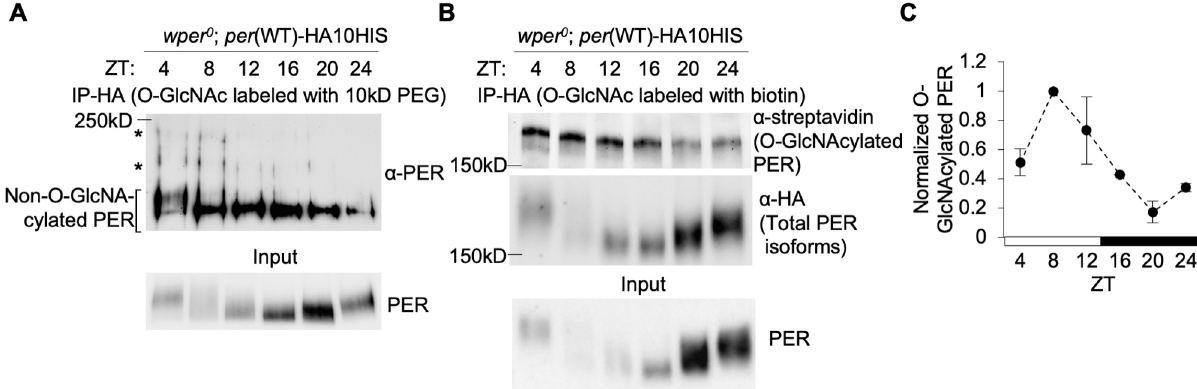
Fig 6. PER O-GlcNAcylation levels show correlation with feeding activity. (A) Western blot showing PER O-GlcNAcylation profile over a circadian cycle. PER proteins were immunoprecipitated by α -HA from head extracts of wper 0 ; p { per(WT)- HA10HIS} flies entrained in 12h:12h LD cycle. O-GlcNAcylated PER was chemoenzymatically labeled with 20-kDa PEG mass tag, resolved by SDS-PAGE, and immunoblotted using α -PER (GP5620) (Top). Slower migrating bands, denoted by asterisks, are O-GlcNAcylated PER while non-glycosylated PER migrates faster. Input for immunoprecipitation and labeling were also directly probed for PER (Bottom). (B) PER proteins were immunoprecipitated by α -HA from head extracts of wper 0 ; p { per(WT)- HA10HIS} flies entrained in 12h:12h LD cycle. O-GlcNAcylated PER was chemoenzymatically labeled with biotin, resolved by SDS-PAGE, and immunoblotted using α -streptavidin (Top) and α -PER (GP5620) (Middle). Input for α -HA IP was immunoblotted with α -PER (Bottom). (C) Quantification of PER O-GlcNAcylation over a circadian cycle as shown in Fig 6B (n = 2). Normalization was performed using the signal for α -HA IP for PER-HA. Error bars = SEM. Rhythmicity of PER O-GlcNAcylation was confirmed by JTK-cycle ( P <